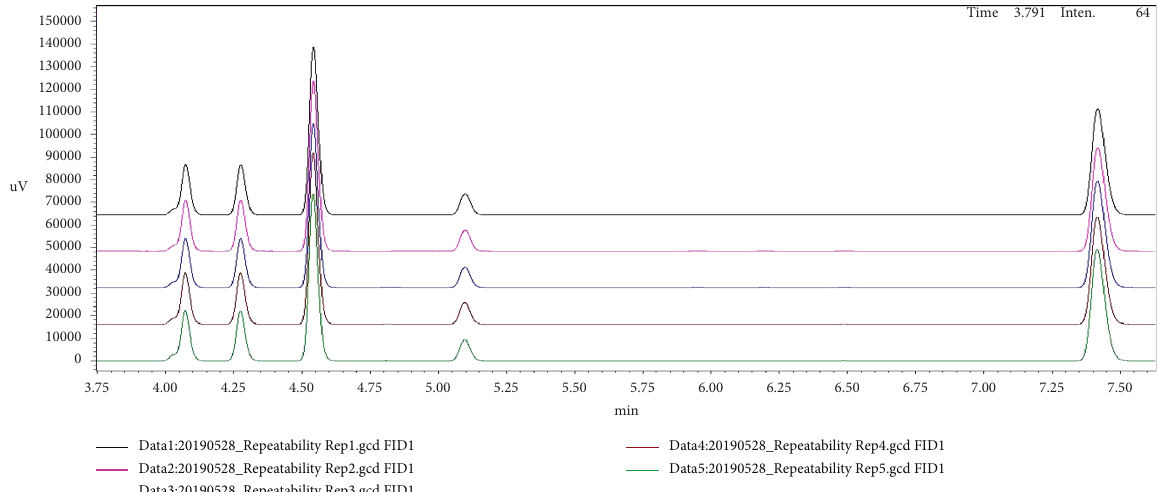
Figure 4: Chromatogram of hexane (34 mg kg − 1 ) and internal standard (68 mg kg − 1 ) showing the repeatability ( n � 5).